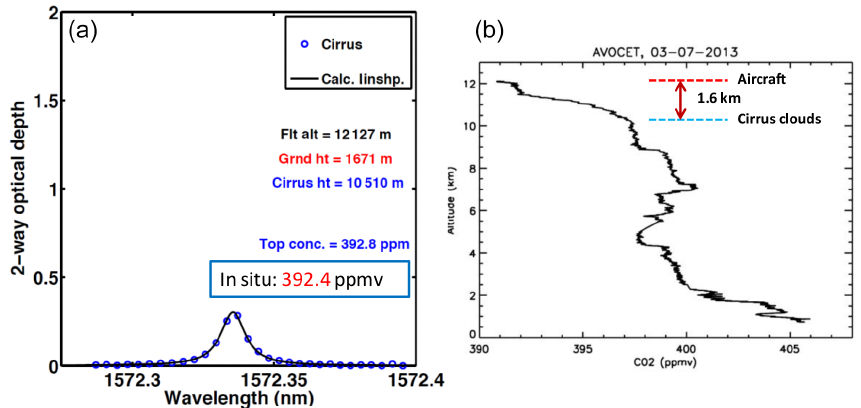
Figure 13. A CO 2 absorption line shape measured on 7 March 2013 to cirrus cloud tops at 10.5km altitude (a) . The lidar measurements are the blue circles, and the fitted line shape is the solid black line. AVOCET in situ vertical profile of CO 2 concentration is plotted in (b) . The aircraft flight altitude was 12.1km, and the lidar range to cirrus cloud tops was